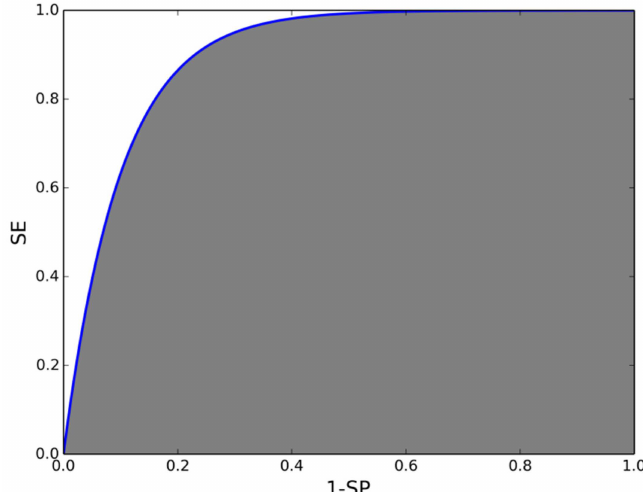
Figure 1. Schematic representation of the ROC curve (blue line). The gray area is the AUC. For a perfect detector this curve has an inverted-L shape, and the area under it covers the whole